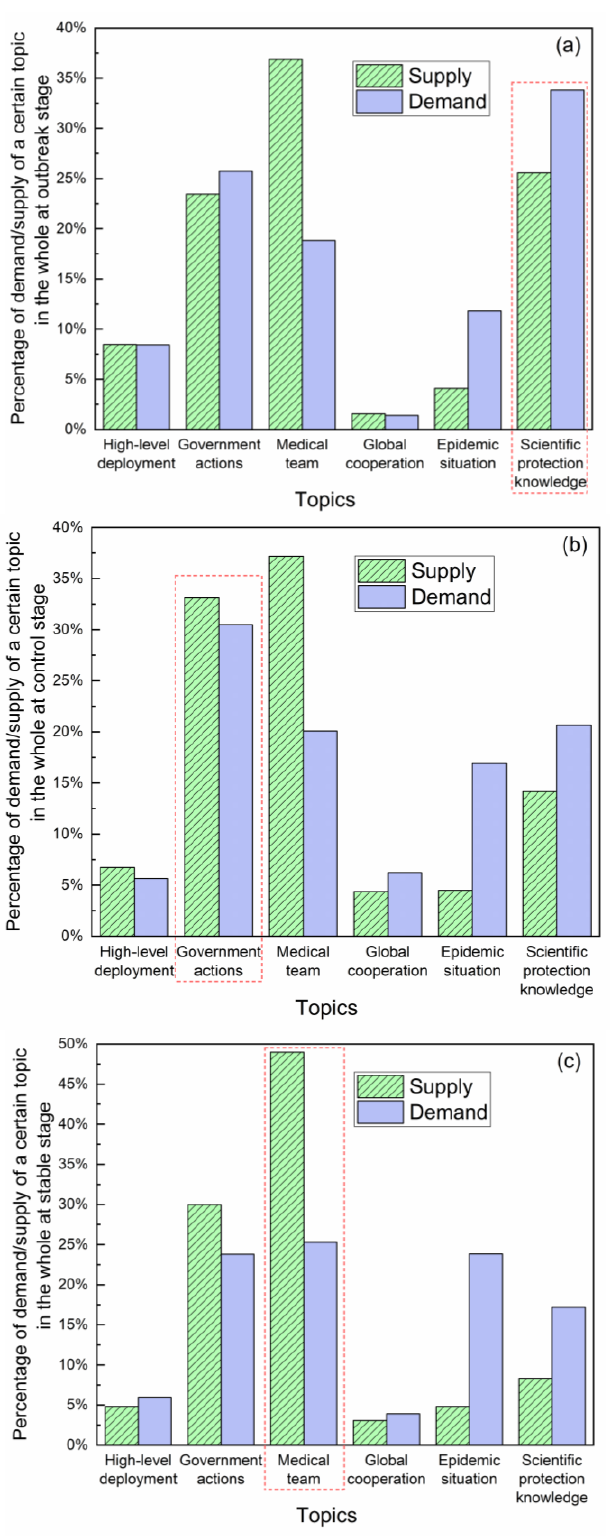
Figure 10. Topic distribution of government supply and public demand at ( a )outbreak stage, ( b )con- trol stage and ( c ) stable stage. ( b ) control stage and ( c ) stable